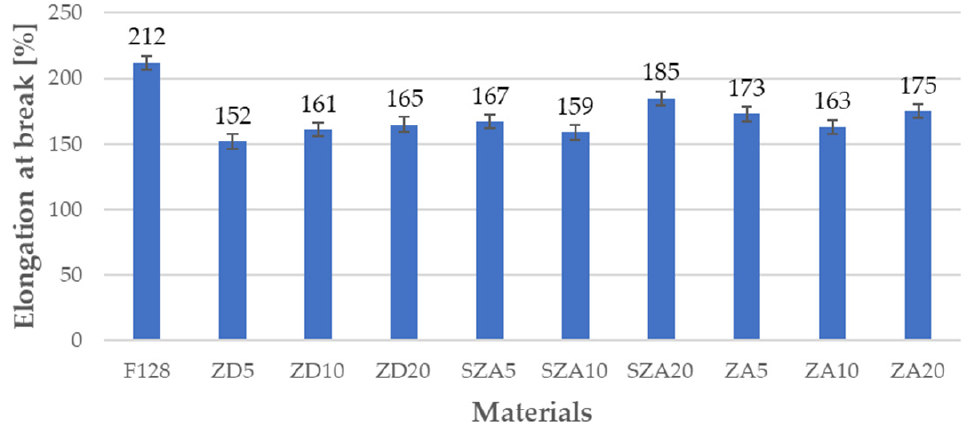
Figure 7. Elongation at break of the tested materials.